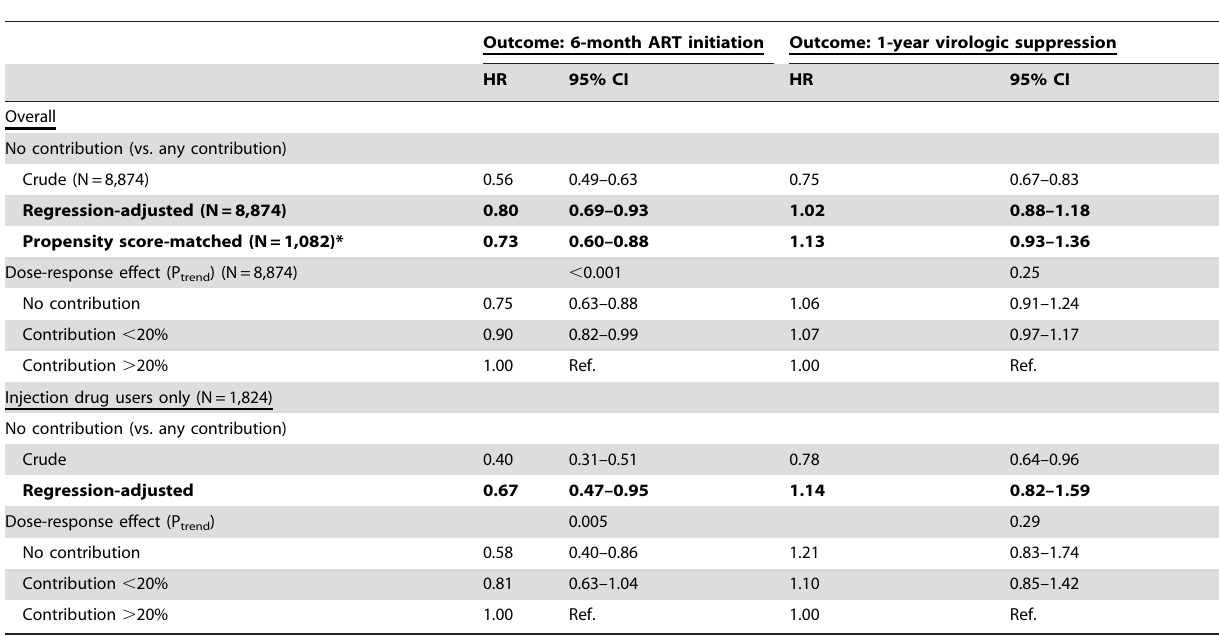
Table 3. Association between living in a state not contributing to the annual ADAP budget and ART initiation and virologic suppression, U.S. NA-ACCORD, 2001–2009.